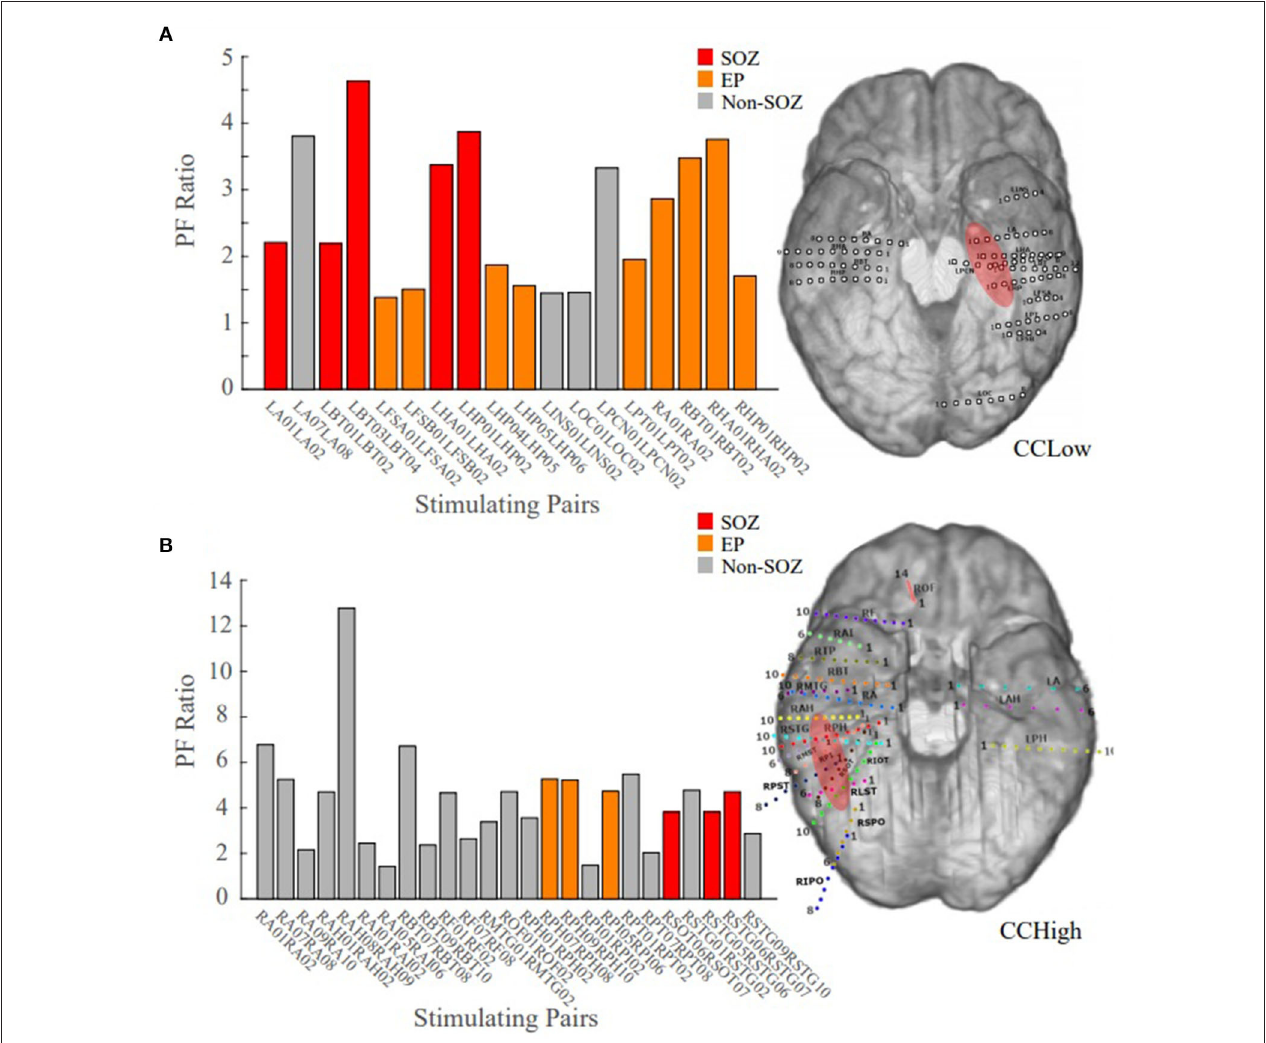
FIGURE 6 | Bar plot of the PF ratios, where red indicates electrode pairs in the clinically annotated seizure onset zone (SOZ), orange indicates early spread (EP), and gray represents all others. To the right of the bar graphs are the electrode implantation maps for each patient with the clinical annotated SOZ denoted in red. (A) PF ratios of representative “model success” Patient 13 dataset; high PF ratio values closely correspond with SOZ and EP regions. (B) PF ratios of representative “model disagreement” Patient 14A dataset; SOZ and EP PF ratios are indistinguishable from non-epileptogenic